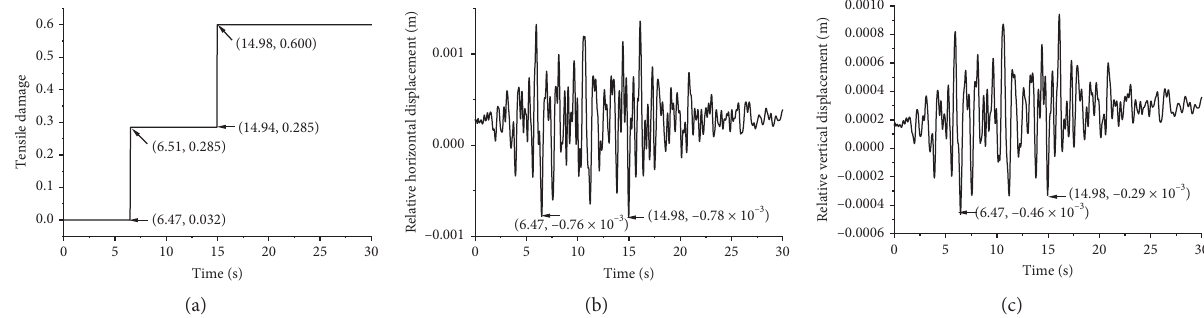
Figure 10: Time histories of relevant variables at the element 3143 for the earthquake overload coefficient of 1.2. (a) Time history of tensile damage variables. (b) The relative horizontal displacement is 0.39mm after the earthquake. (c) The relative vertical displacement is 0.34mm after the earthquake.